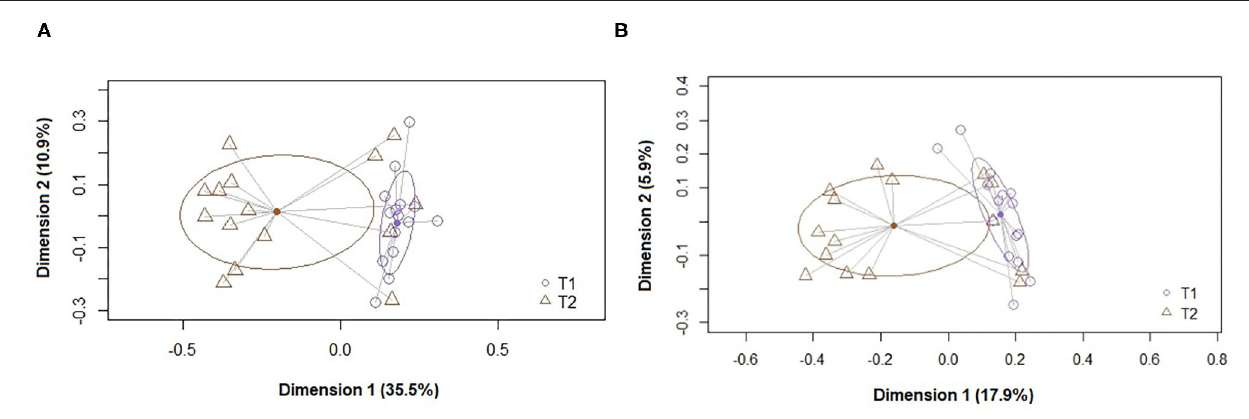
FIGURE 1 | Principal coordinate analysis (PCoA) plots of bacterial profiles at the genus level based on (A) the Bray-Curtis dissimilarity analysis (relative abundance) and (B) the Jaccard’s coefficient for binary data (presence or absence). The values on each axis label represent the percentage of the total variance explained by that axis. The differences between the groups of fecal samples (T1, T2) were analyzed using the PERMANOVA test with 999